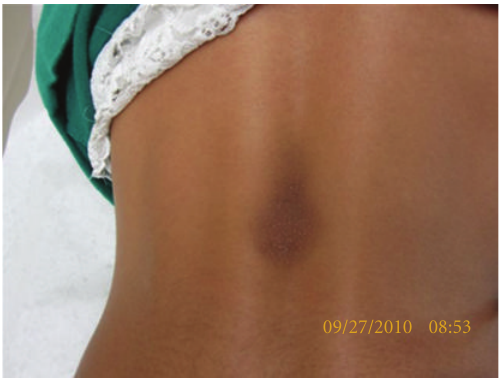
Figure 1: Hyperpigmented plaque on midback.